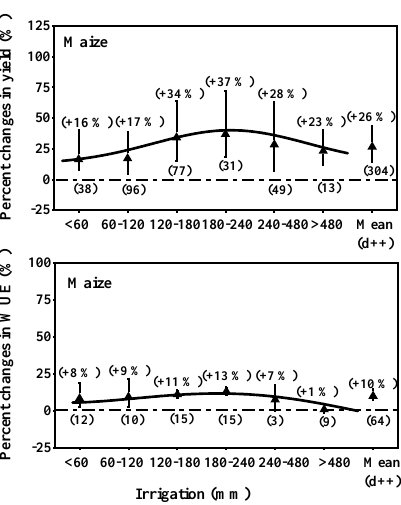
Figure 5. Percent changes in crop yields and WUE according to irrigation (mm), expressed as the mean value with bias-corrected 95% confidence intervals. Percentage change and observation numbers for each group are given in parentheses. The solid lines are fitted by non-linear regression model to percent changes datasets. Triangles represent field experiment of maize and squares represent field experiment of wheat.